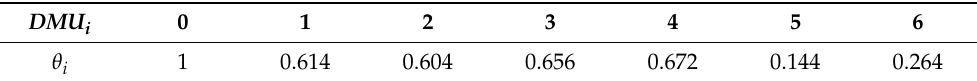
Table 7. Efficiency value of each DMU.